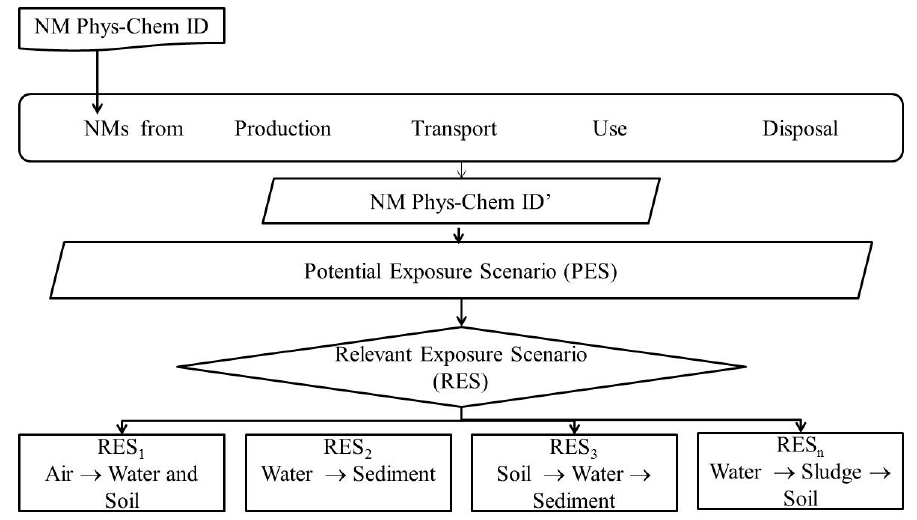
Figure 7. Identification of Relevant Exposure Scenarios (RES) based on identified release along the NMs life cycle, the NMs characteristics at each point, and the Potential Exposure Scenarios for such release.